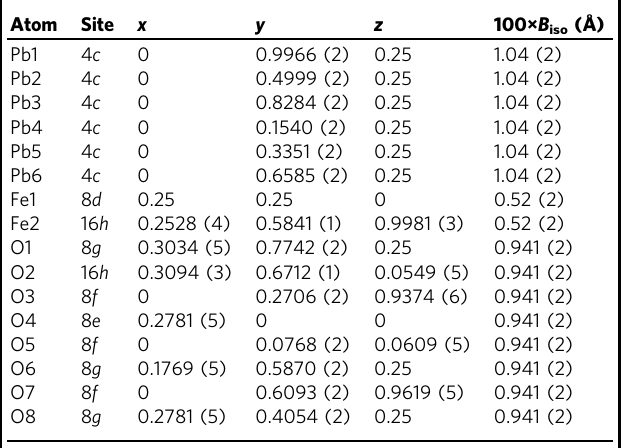
Table 2) reveal that the lead atoms, located at the three positions (Pb1, Pb2, and Pb3), show a valence state close to + 2, but the other three (Pb4, Pb5, and Pb6) provide valence sums corre- sponding to a valence state close to + 4. However, Fe always shows a + 3 state regardless of its atomic positions. These features